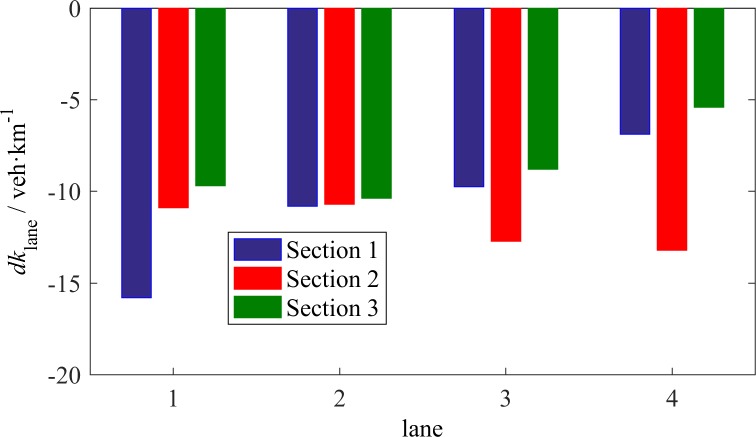
Average dklane that corresponds to LC vehicles in each lane.